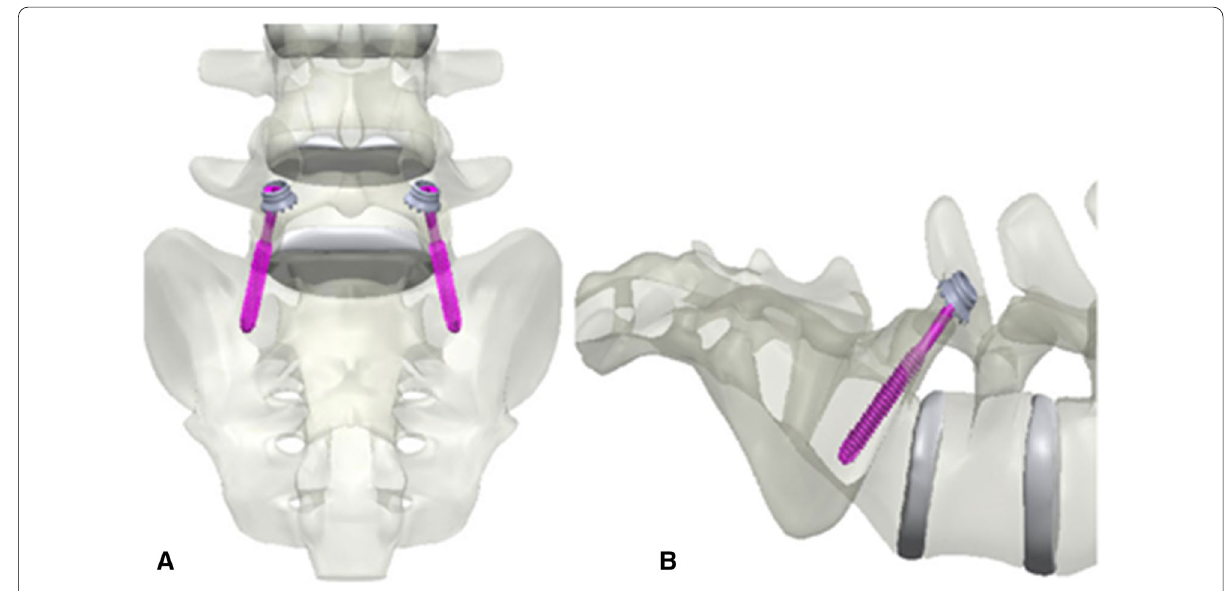
Fig. 6 Bilateral TFPS at L5–S1. A Anterior–posterior view, B Lateral view [17]